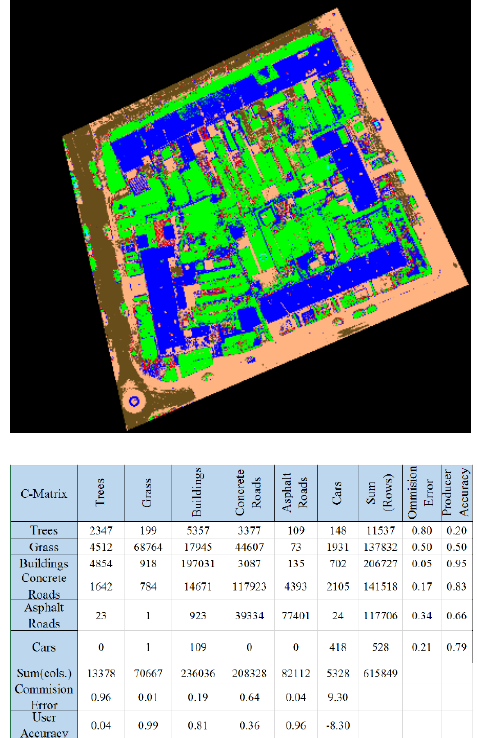
Figure 6. Obtained results from Bayesian classifiers based on merely orthophoto.